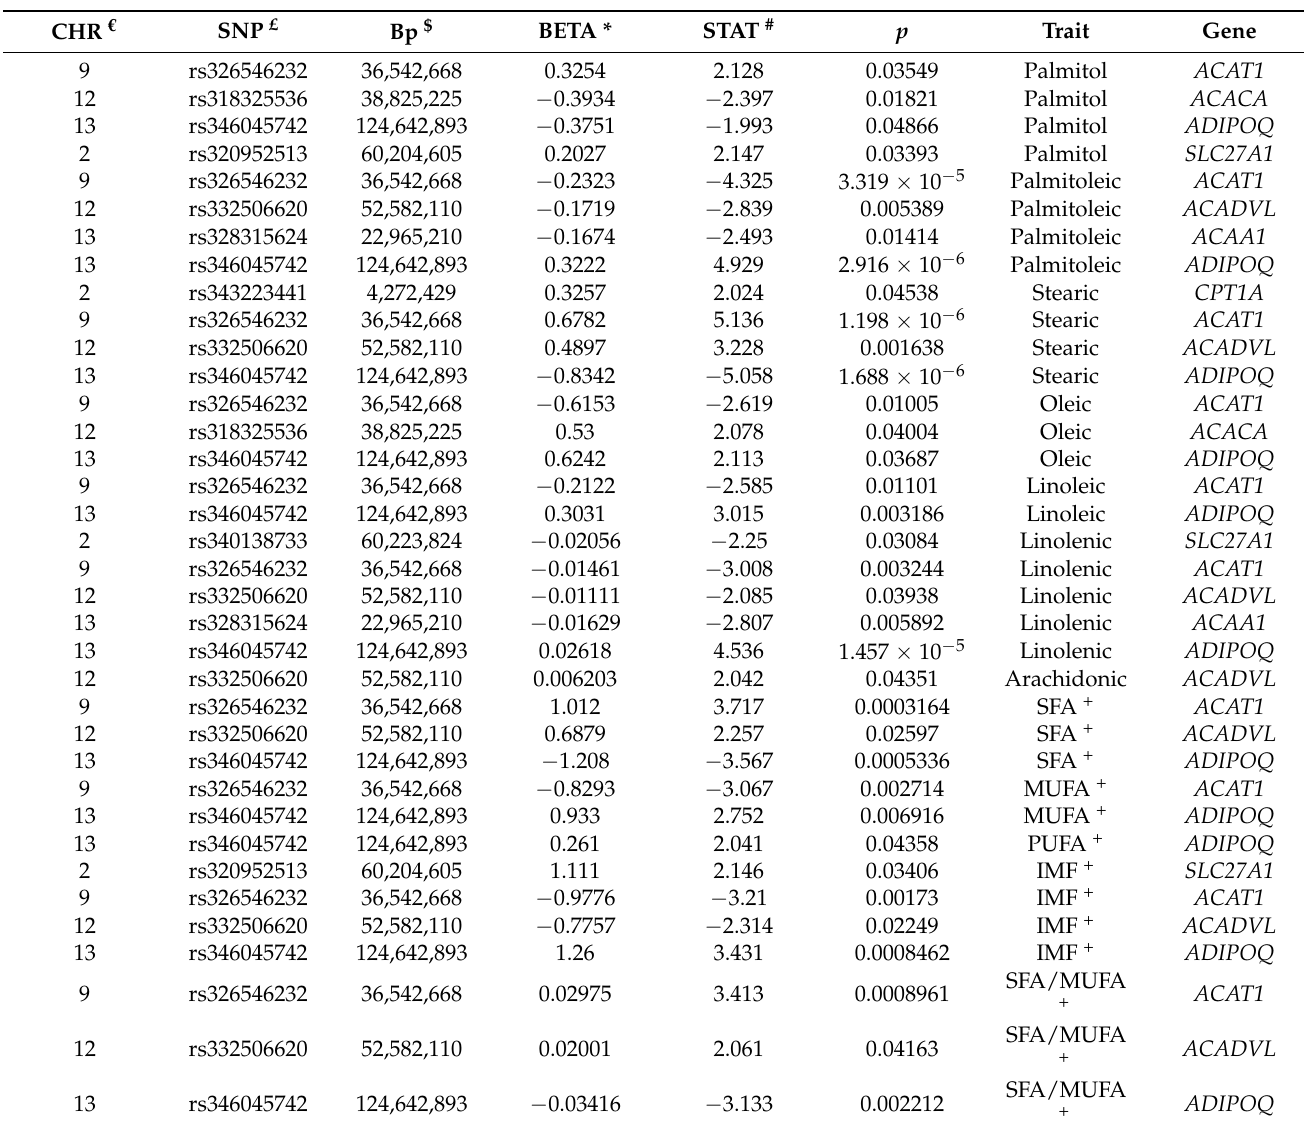
Table 3. Genes interestingly associated ( p -value < 2 × 10 − 3 ) with the main fatty acids of the intramuscular